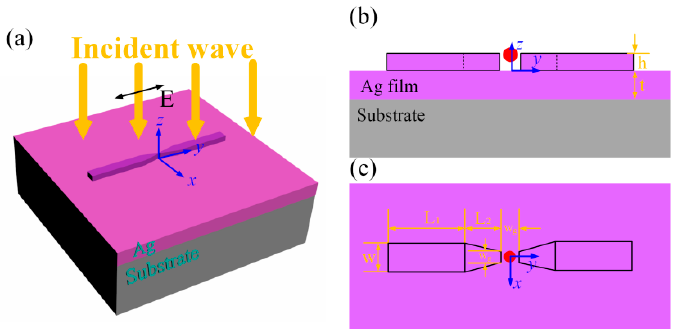
Figure 1. ( a ) Schematic diagram of the proposed silver nanoantenna on a silver film. ( b ) Side view of the structure in the y-z plane. ( c ) Top view of the structure in the x-y plane.